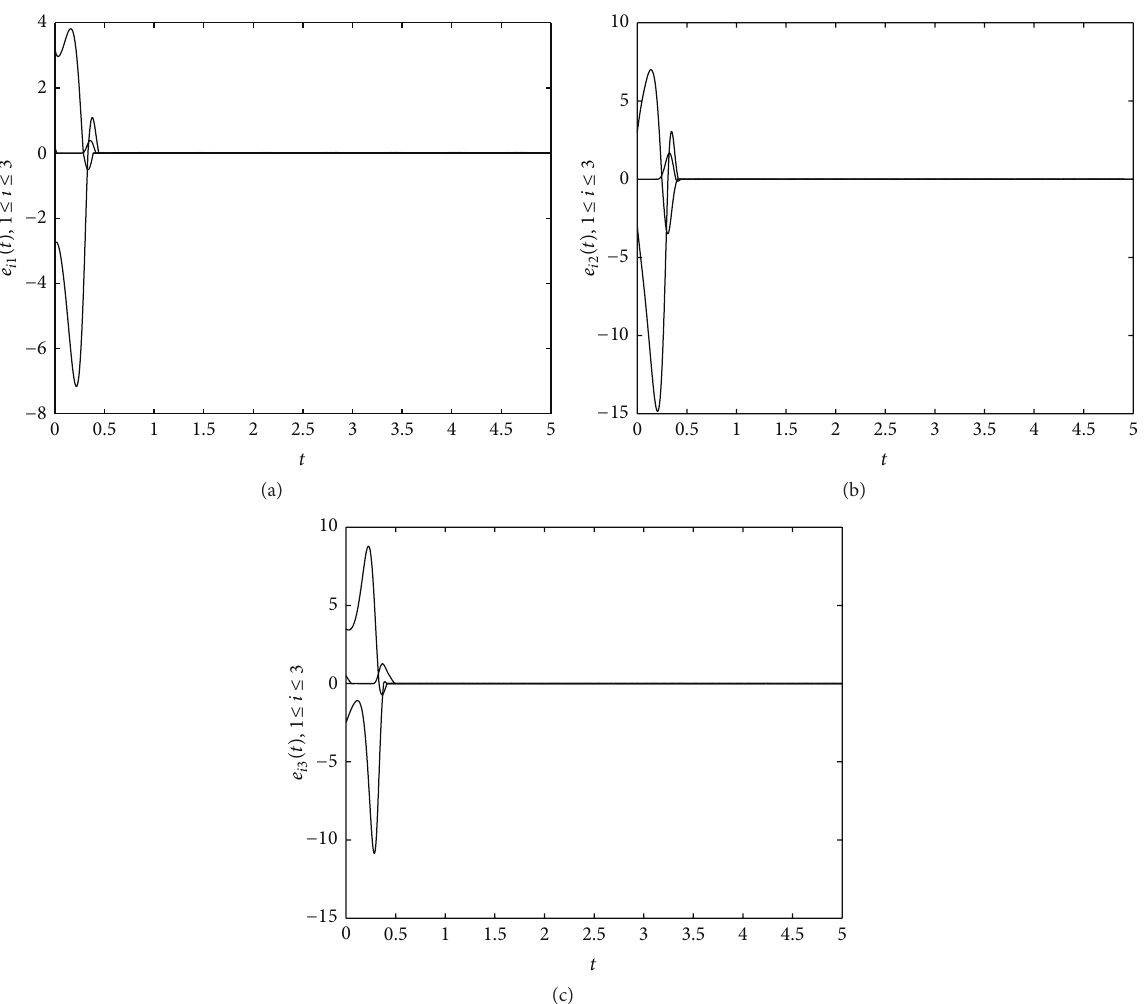
Figure 3: Synchronization errors of (47): (a) 𝑒 𝑖1 (𝑡) , (b) 𝑒 𝑖2 (𝑡) , (c) 𝑒 𝑖3 (𝑡), 𝑖 = 1,2, 3 .